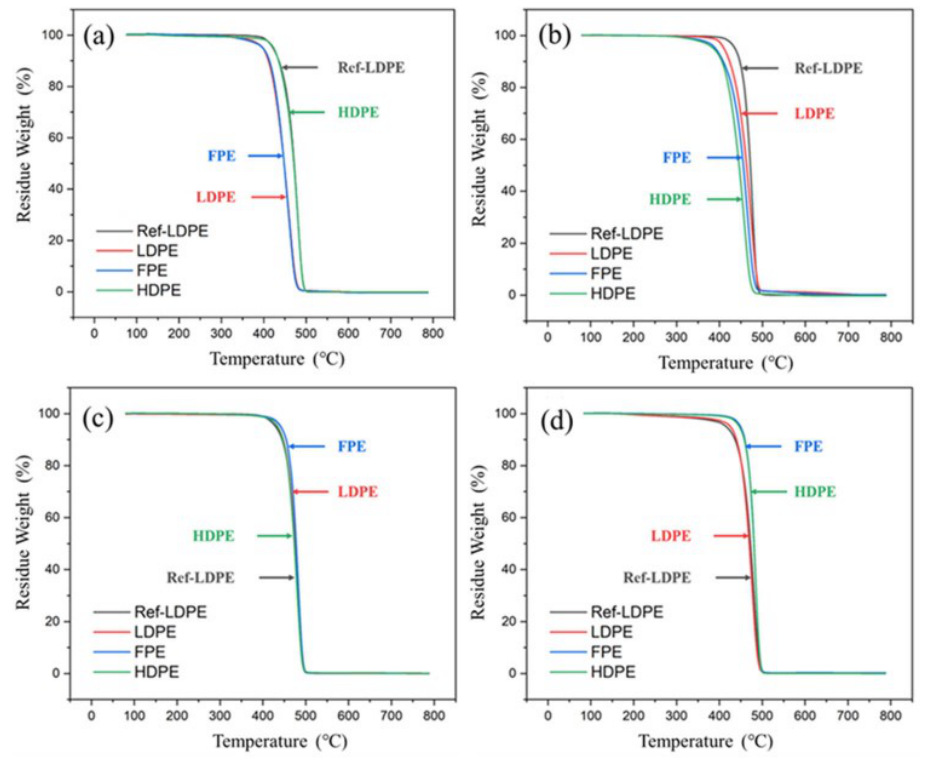
Figure 7. TGA curves of unaged PE samples in the N 2 atmosphere with different thermal aging durations. ( a ) 0 h, ( b ) 10 h, ( c ) 100 h, and ( d ) 360